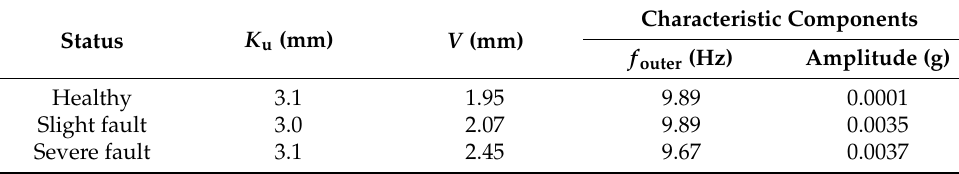
Table 9. Bearing cage fault diagnosis results of the Y100L2-4 motor with a full load.